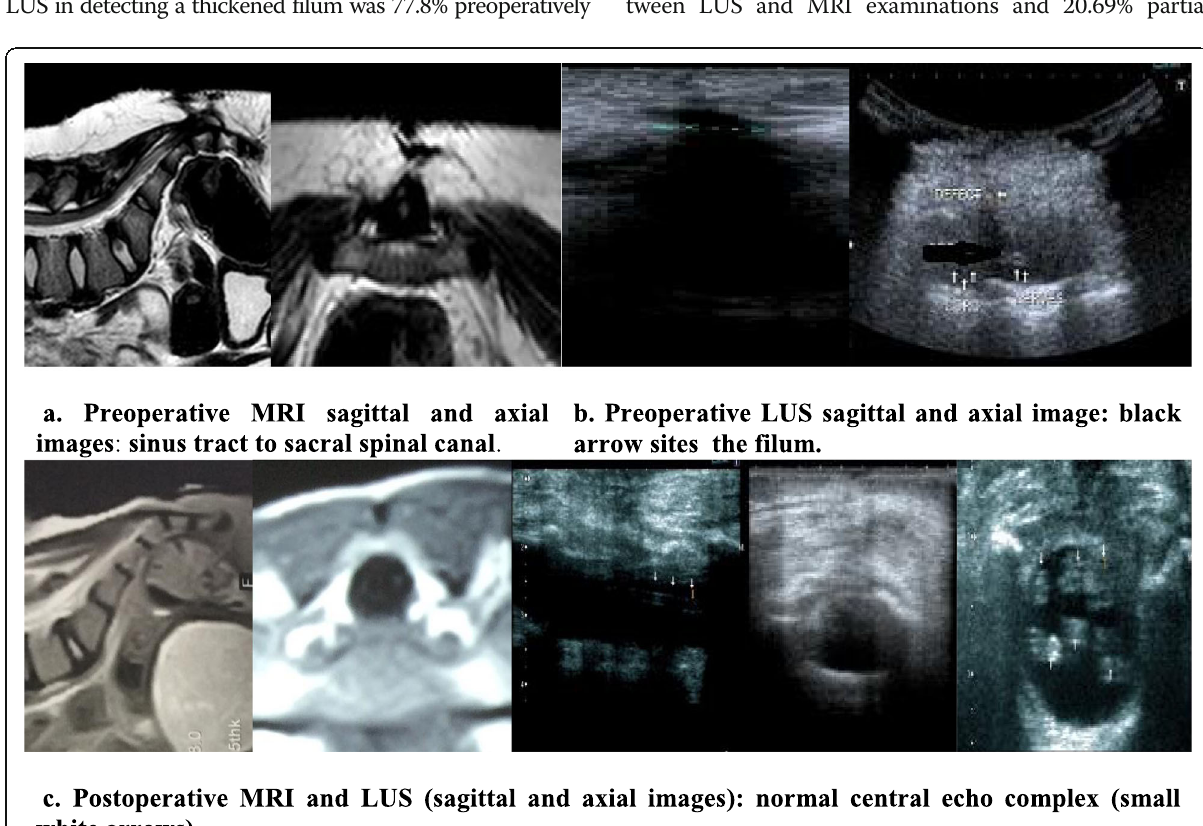
Fig. 2 Skin dimple at the lower back. a Preoperative MRI sagittal and axial images: sinus tract to sacral spinal canal. b Preoperative LUS sagittal and axial image: black arrow sites the filum. c Postoperative MRI and LUS (sagittal and axial images): normal central echo complex (small white